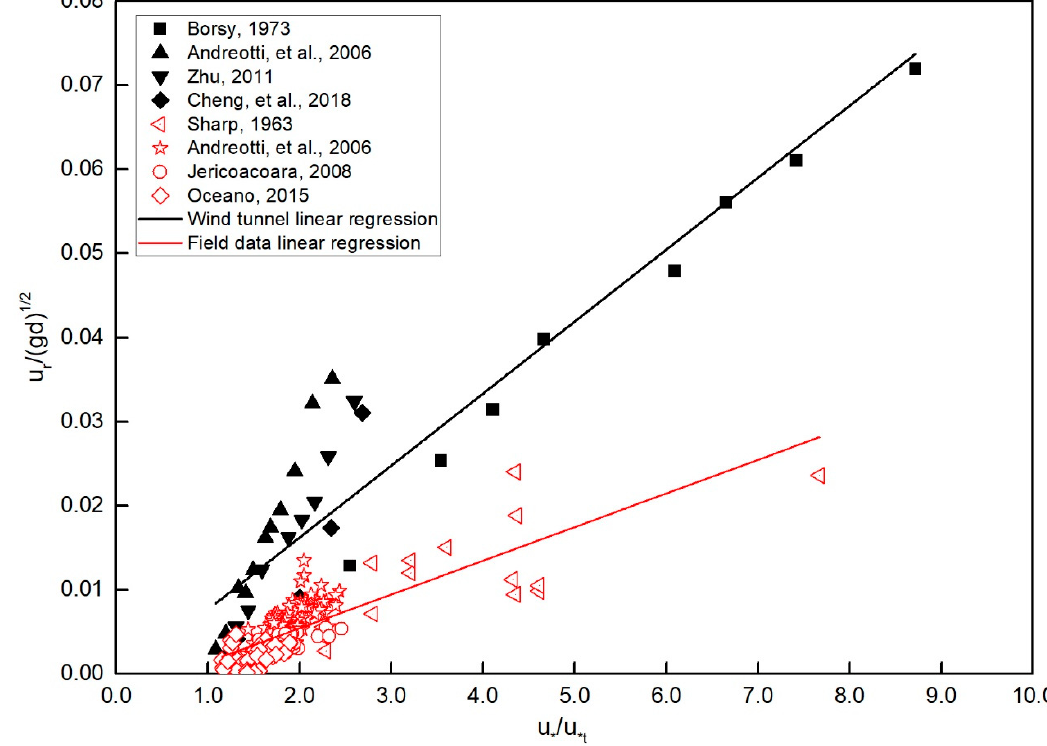
Figure 4. These analyses included only data that met the quality control criteria. The dimensionless migration rates for equilibrium ripples as a function of dimensionless shear velocity, segregated as wind tunnel (black symbols: n = 34; R 2 = 0.86) or field data (red symbols: n = 161; R 2 = 0.63).